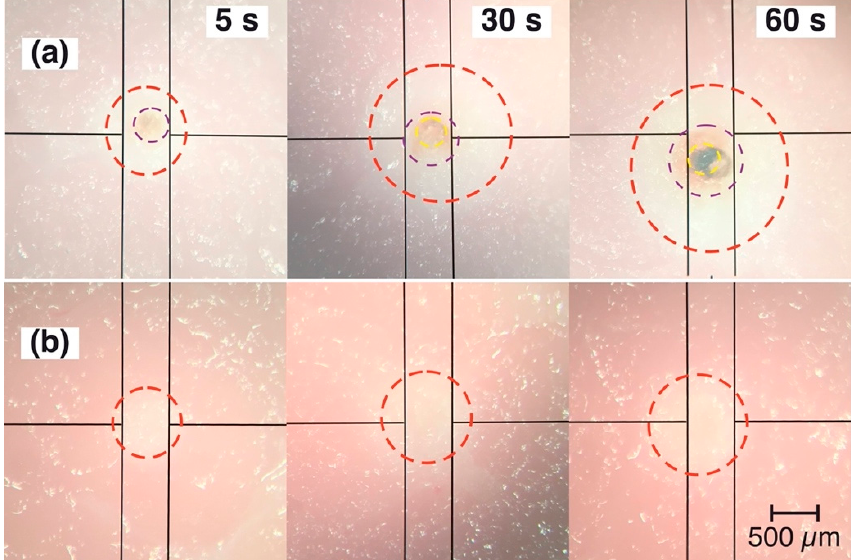
Figure 3. Microphotographs of the porcine longissimus muscle tissue surface after exposure by ( a ) USP Ho-doped fiber laser system with an average power of 0.3 W; ( b ) CW Ho-doped fiber laser with a power of 0.3 W [41]. Scale bar—500 μ m.